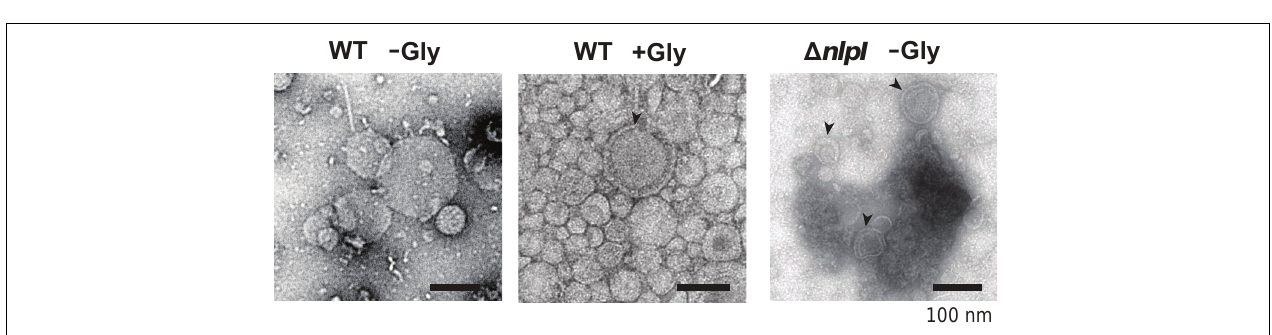
FIGURE 5 | Effect of glycine on membrane permeability. E. coli BW25113 was grown to the late exponential phase in the presence and absence of 1% glycine. (A) Membrane permeability analyses using SYTO9 and propidium iodide (PI). Bacterial cells exhibiting membrane integrity and deficiency were labeled green and red, respectively. Representative images are presented. Bar = 100 µ m. (B) The percentages of SYTO9- and PI-labeled cells. The data are presented as the mean ± standard deviation from more than three representative images. * *P < 0.005 compared to the control (-Gly). (C) Cell viability in the presence and absence of glycine. Bacterial cells were adjusted to equal optical densities (OD 600 = 1.0), diluted samples were plated onto LB agar, and colony forming units (CFUs) were calculated. The data are presented as the mean ± standard deviation from three replicates. (D) The permeability of the outer membrane was assessed by measuring the fluorescence of 1- N -phenylnaphthylamine (NPN), and the values relative to that of control are presented. The data are presented as the mean ± standard deviation from three replicates. * *P < 0.005 compared to the control (-Gly).